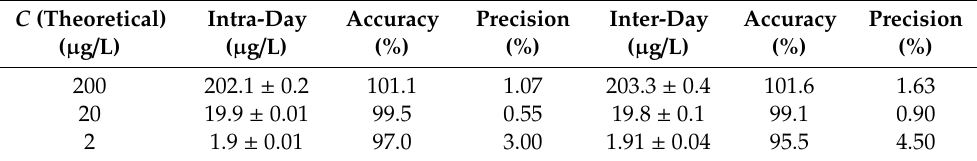
Table 3. Validation parameters for intra-day and inter-day accuracy and precision ( n ’ =